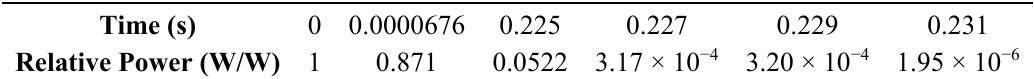
Table 2. Channel impulse response for a distance of 100